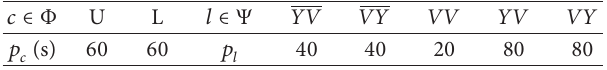
Table 3: The parameters of processing